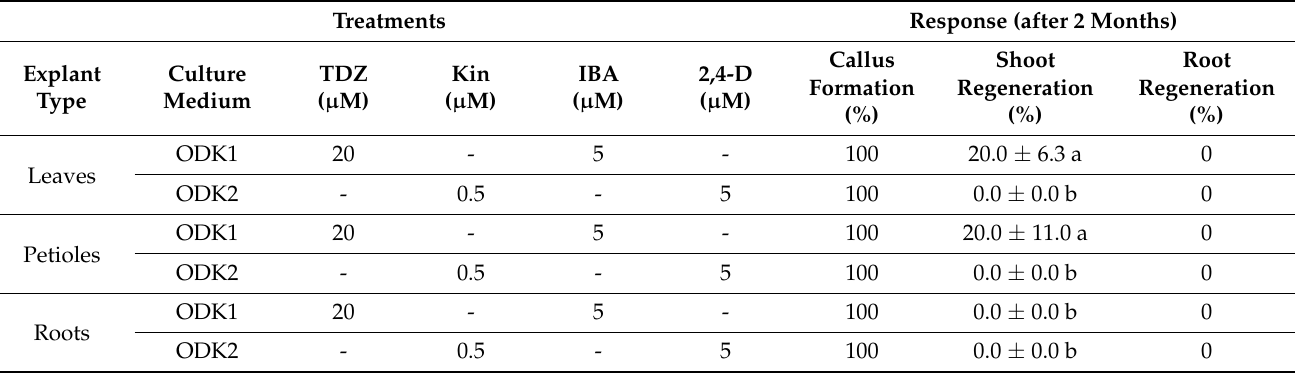
Table 1. Effect of three different explant types (leaves, petioles, roots) of O. dictamnus L. and two different media on callus formation, shoot and root regeneration (%) after a 2-month period.